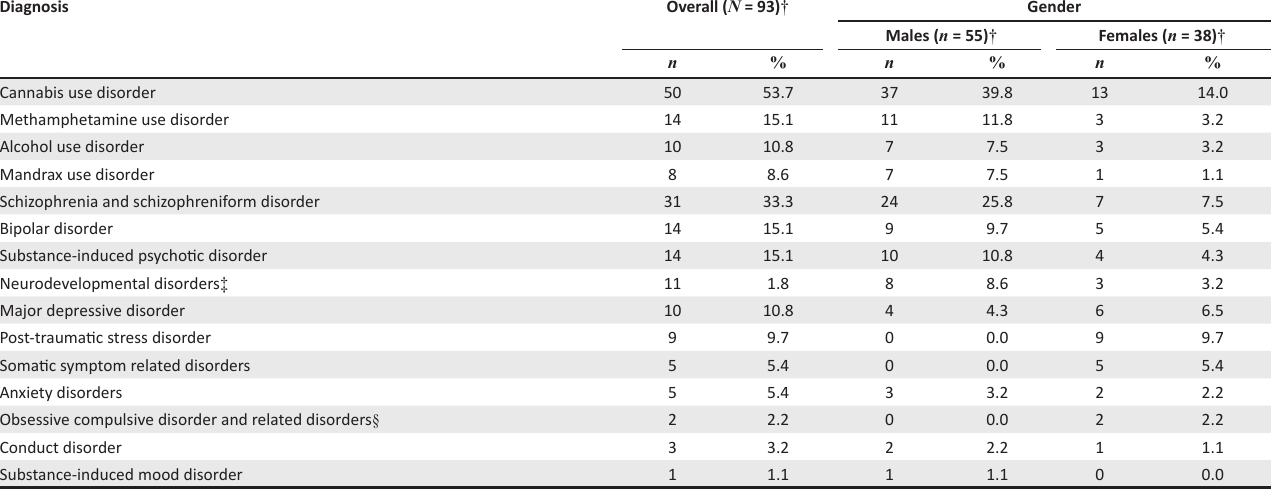
TABLE 1: Frequency, n ( % ), of psychiatric diagnoses among adolescents ( N = 93), recorded at discharge. Diagnosis